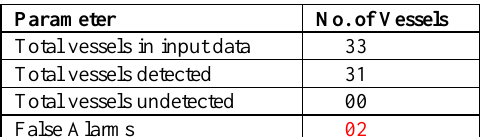
Figure 4, and Figure 6 show the output for sub-images of Figure 3 and 5 respectively. Figure 4, table 2 together indicate that, one vessel is undetected (Highlighted by black rectangle in Figure 3 and yellow circle in Figure 4). It is because there is very less space between these two vessels and the post-processing operation, due to which they merged and displayed as one single ship. In Figure 6, yellow circle and table 3 indicate